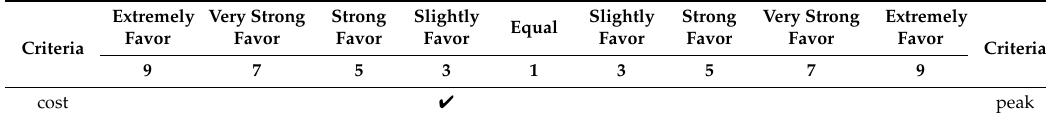
Table 3. Third evaluators’ comparison according to Saaty’s scale.